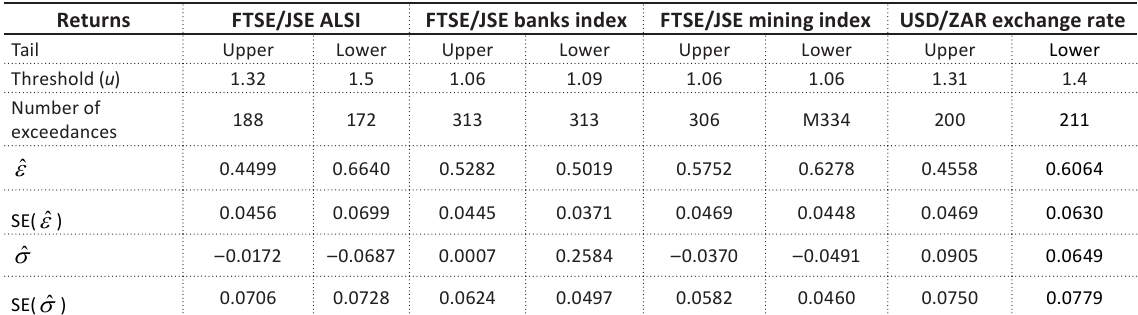
Table 5. ML parameter estimates of hybrid GARCH-type-GPD model